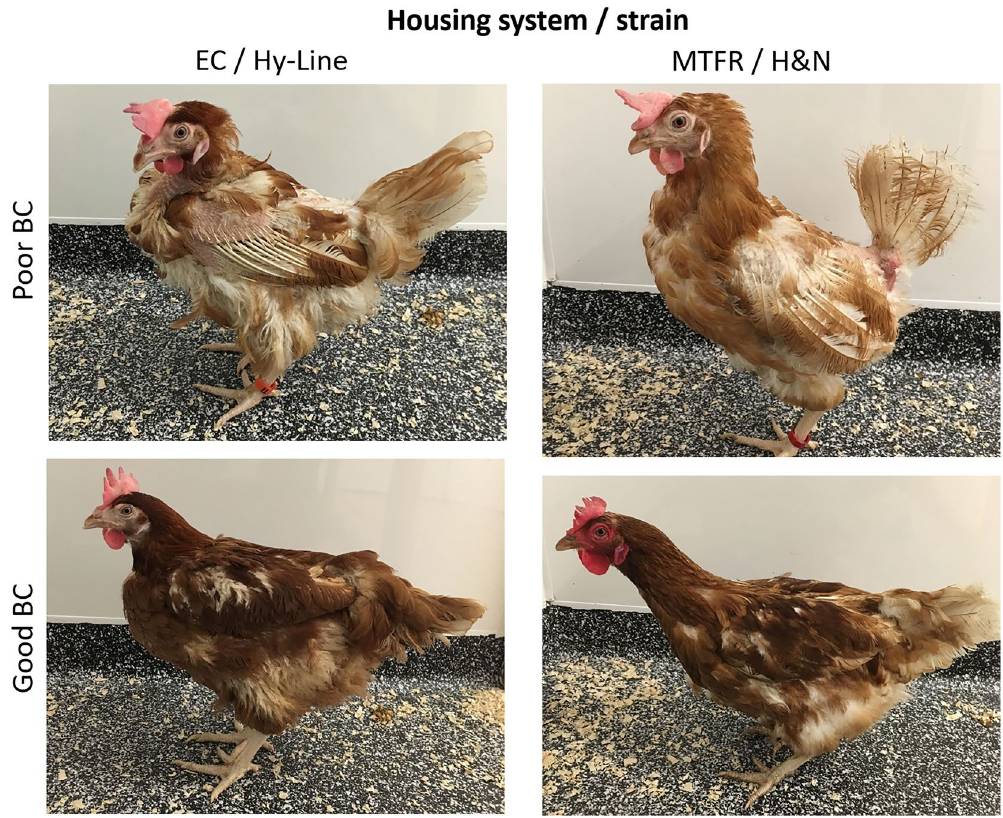
Figure 1. Representative images of hens of both strains (Hy-Line and H&N) with good and poor body conditions (BCs) sampled from the two housing systems: enriched cages (EC) and multi-tier aviary with free range